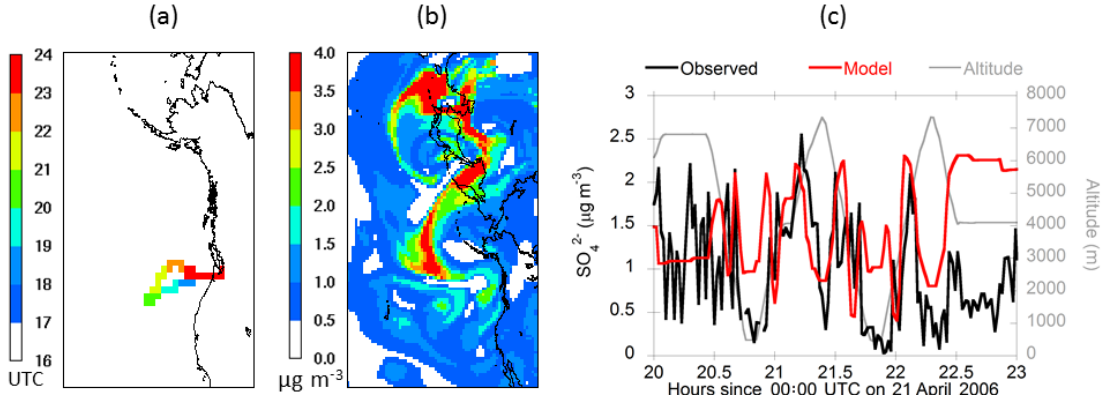
Figure 6. Simulation of the impact of transpacific transport on 3-D distributions of SO 2 − aerosol on 21 April 2006. (a) Flight path of C-130 4 aircraft color-coded by hour (UTC). (b) Simulated SO 2 − distribution at 4km altitude on 21 April 2006 at 21:00UTC. (c) Comparison of 4 modeled and observed SO 2 − aerosol concentrations along C-130 flight path. 4